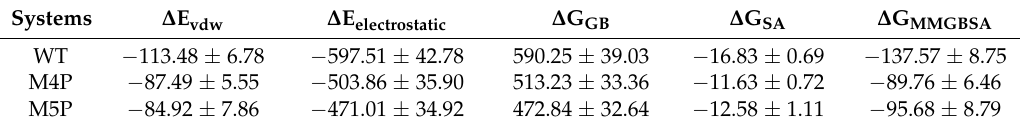
Table 1. Comparison of binding energy components between Shank3 N-PDZ and SAPAP E-PBM in three complex